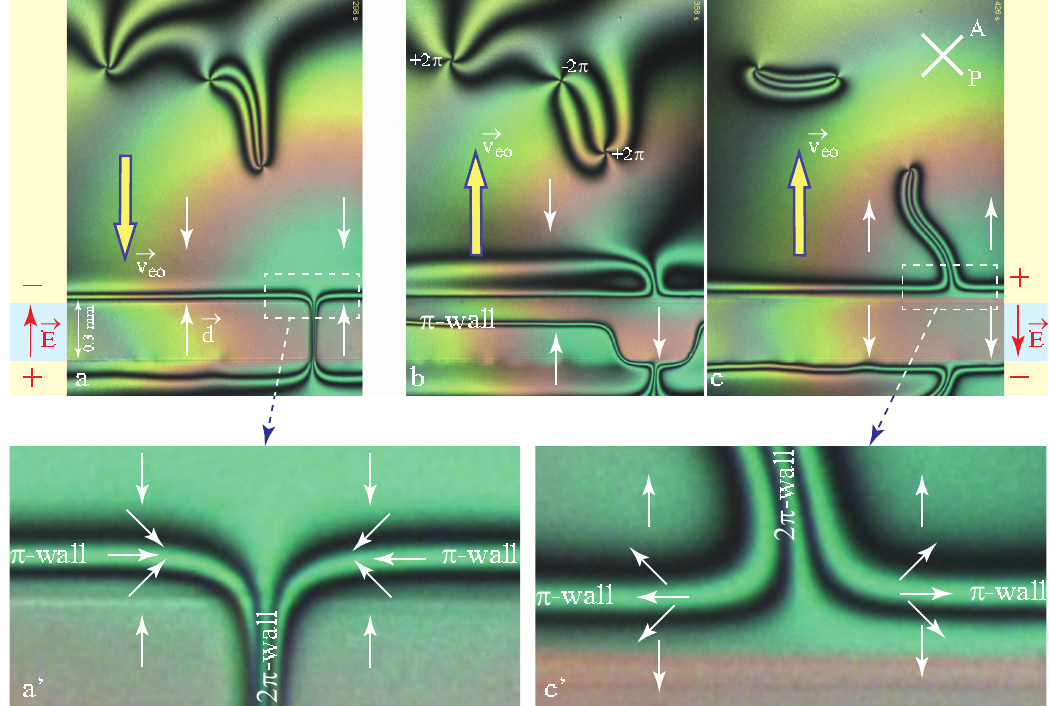
Figure 12. Simultaneous evidence for the flexo-electric polarisation of the dowser texture and for the electro-osmotic flows in 5CB. ( a , a’ ) Application of an electric field by the one-gap system of electrodes. Due to its flexo-electric polarisation, the dowser field d is aligned by the electric field E inside the gap. π -walls are generated at edges of the gap because outside of the gap, the dowser field d is aligned in the opposite direction by the electro-osmotic flow v eo . ( b ) Transitory splitting of the 2 π -wall and motions of π -walls due the reversal of the electric field. ( c , c’ ) Alignment of the dowser field by the reversed electric field and electro-osmotic